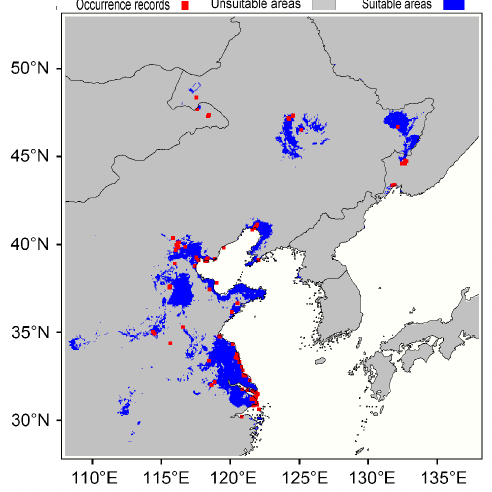
Figure 4. Binary habitat suitability output for Paradoxornis heudei based on current climatic conditions. The blue color indicates a suitable range, while the gray color represents an unsuitable range for the habitat. The red squares represent the occurrence records of Paradoxornis heudei .